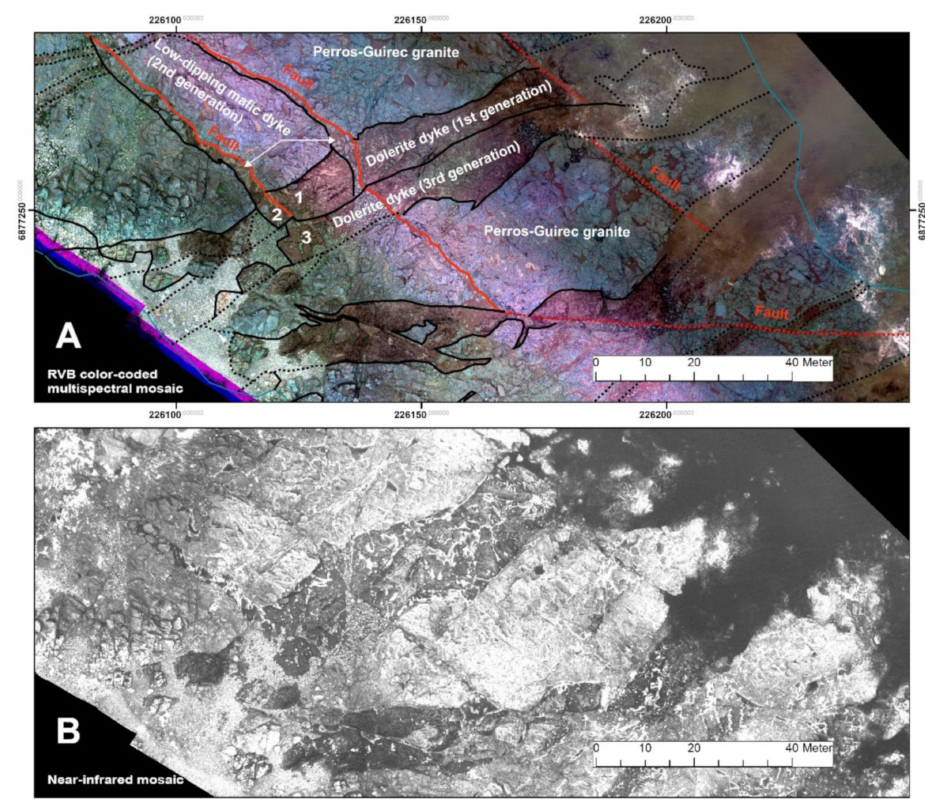
Figure 3. Extracts of ( A ) the RVB color-coded multispectral and ( B ) near-infrared mosaics on a subarea of the southern block (Trestraou sector) surveyed by drone. In ( A ) detailed geological contours (in black) and faults (in red) are superimposed, derived from the joint interpretation of field observations and the mosaics. Relations between the three generations of mafic dykes are highlighted: The first generation NE-SW-trending mafic dyke (dolerite), noted 1, is crosscut by the second generation of NW-SE mafic dyke (noted 2) emplaced within low-dipping reverse faults (in red). 1 and 2 are both crosscut by the third generation (noted 3) of NE-SW-trending mafic dyke